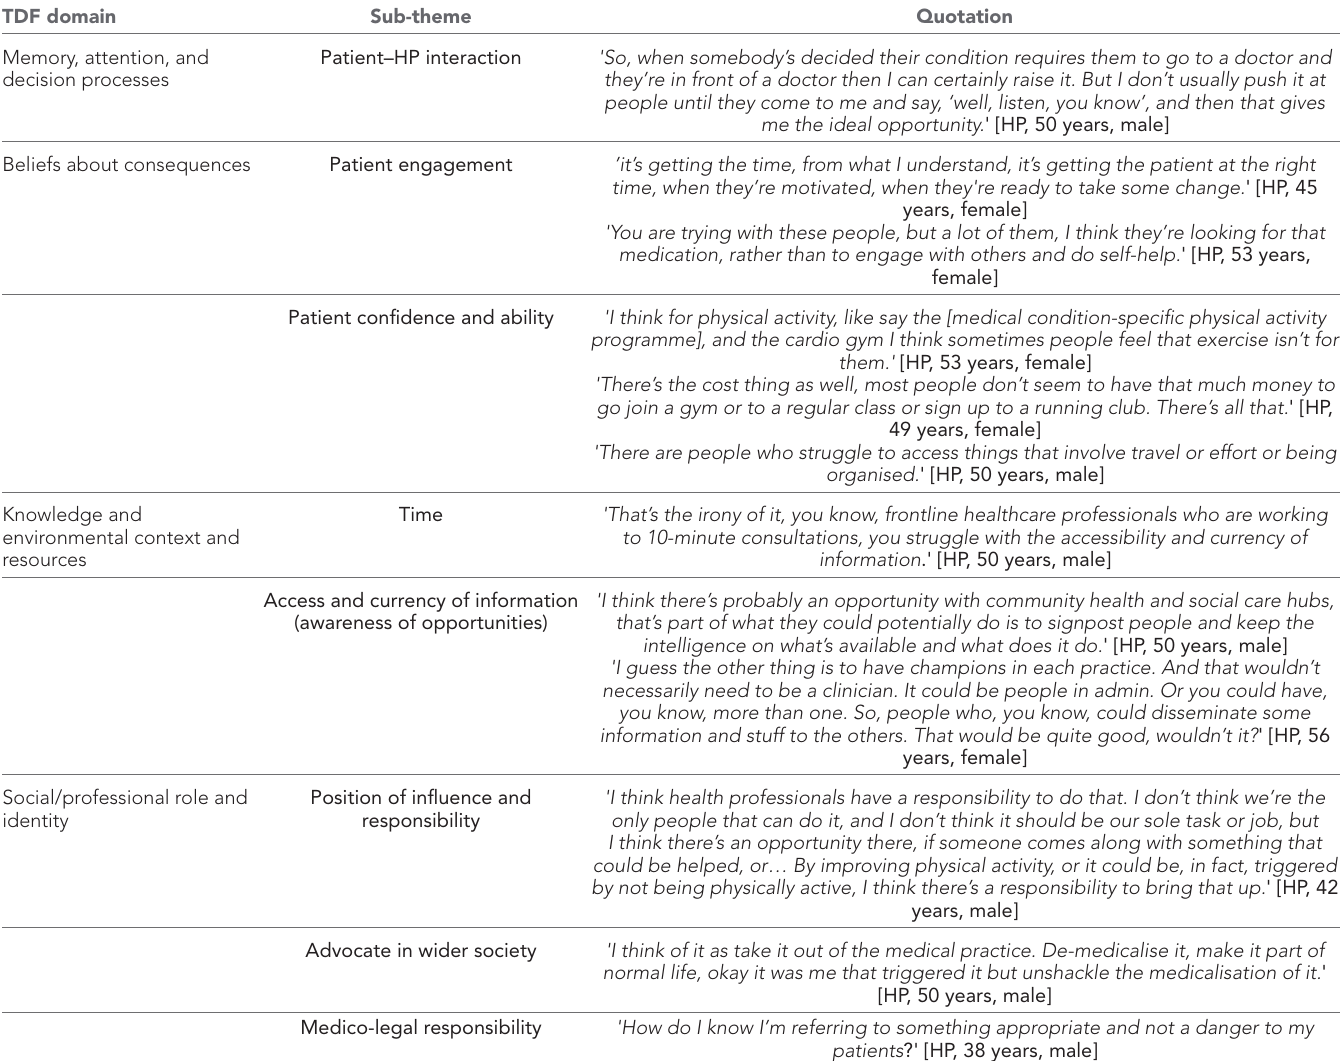
Table 2 HP quotations for emergent domain themes and sub- themes TDF